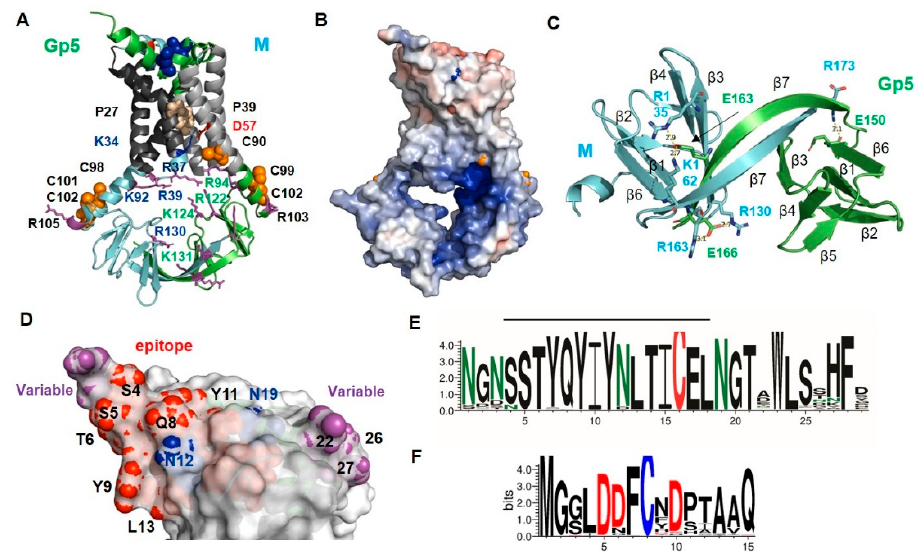
Figure 6. The predicted structure of Gp5/M of PRRSV-1 prototype strain Lelystad. ( A ) Cartoon model. Ecto- and endodomains are colored green in Gp5 and cyan in M. Hydrophobic membrane parts of Gp5 are colored dark grey and of M are colored light grey. N-glycosylated Asn are shown as blue sticks, and the disulfide bond between Gp5 and M are shown as red sticks. Conserved Pro in TM1 of Gp5 and M are shown as wheat sphere. The amino acids forming an electrostatic interaction between TM2 of Gp5 (D57) and TM1 of M (K34) are shown as sticks. Palmitoylated Cys in Gp5 and M are highlighted as orange spheres, and basic amino acids in the endodomain are shown as magenta sticks. See Figure S9 for the corresponding quality scores of the model. ( B ) Electrostatic surface potential. The orange spheres are the acylation sites in Gp5 and M. ( C ) Cartoon of the endodomain, Gp5 in green and M in cyan. The numbering of the β -strands is indicated. Gp5 and M interact mainly via parts of β -strands 7 and via three salt bridges. The carboxyl-group of Glu166 in β 7 of Gp5 interacts with the guanidino groups of Arg163 (located in β 7) and Arg130 (in β 3) in M. In a similar manner, Glu163 in β 7 of Gp5 interacts with Arg135 (in β 3) and with the amine group of Lys162 (located in β 7) in M. Finally, Arg 173 at the C-terminus of β 7 in M interacts with Glu150 in β 6 of Gp5. ( D ) Surface representation of the ectodomain. N-glycosylation sites are shown as blue spheres, and between PRRSV-1 strains, variable amino acids are shown as magenta spheres. Amino acids of the neutralizing epitope (residues 5–18) are highlighted as red spheres. ( E , F ) Web logo showing the amino acids at each position in the ectodomain of Gp5 ( E ) and M ( F ). Logos were generated from 1077 aligned Gp5 and 83 aligned M amino acid sequences from PRRSV-1 strains. The overall height of the stack indicates the sequence conservation at a position (x-axis), while the height of symbols within the stack indicates the relative frequency of each amino. Asn residues are labeled green; Cys are labeled red in E and blue in F; and Asp residues in F are labeled red. A graph showing the percent amino acid conservation at each position is shown in Figure S13. The epitope in Gp5 is marked with a black line. Note that the numbering of amino acids starts with the first residue in the mature protein and therefore 34 must be added to obtain the number in the protein, including its signal peptide.